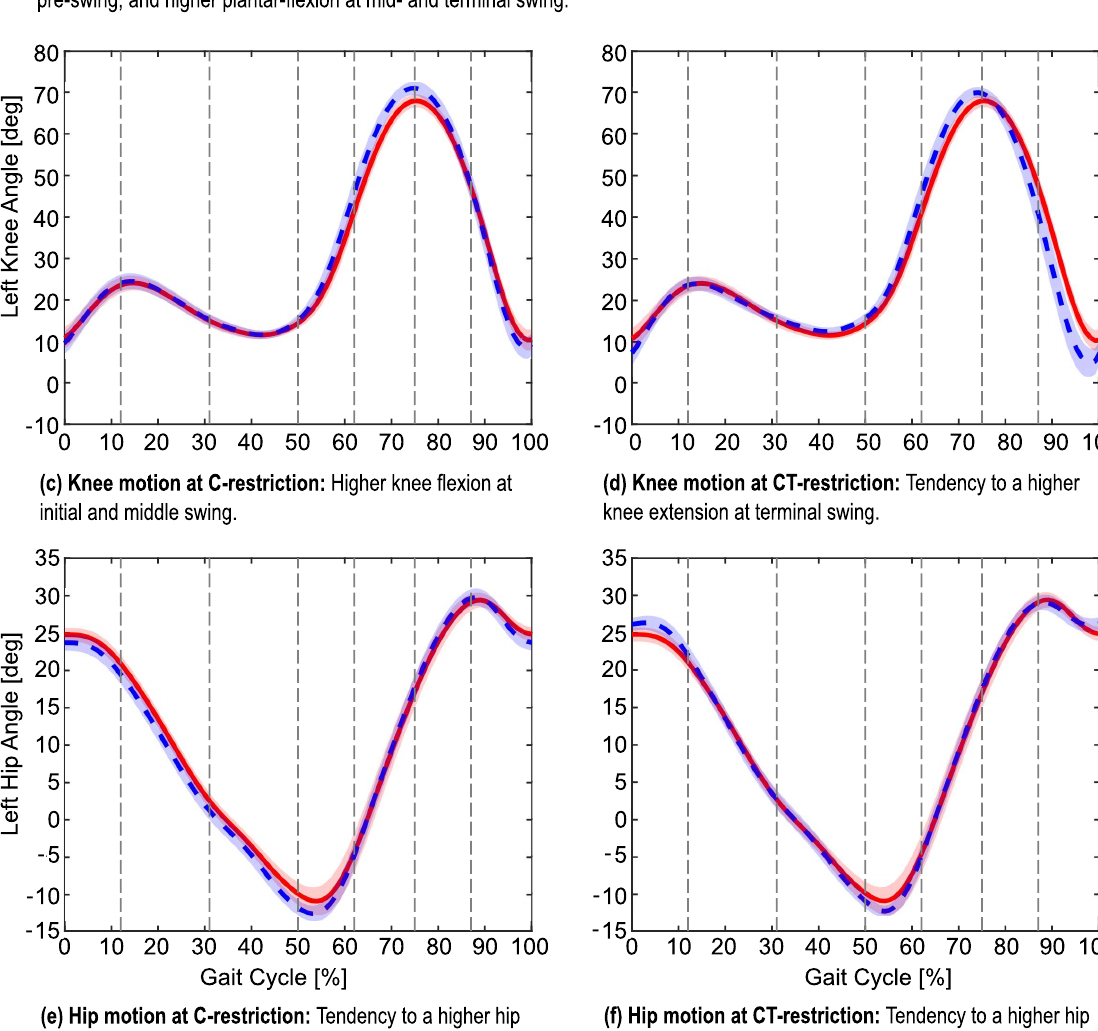
Figure 3. Joint motion of a representative subject, showing the typical motion seen in the majority of the